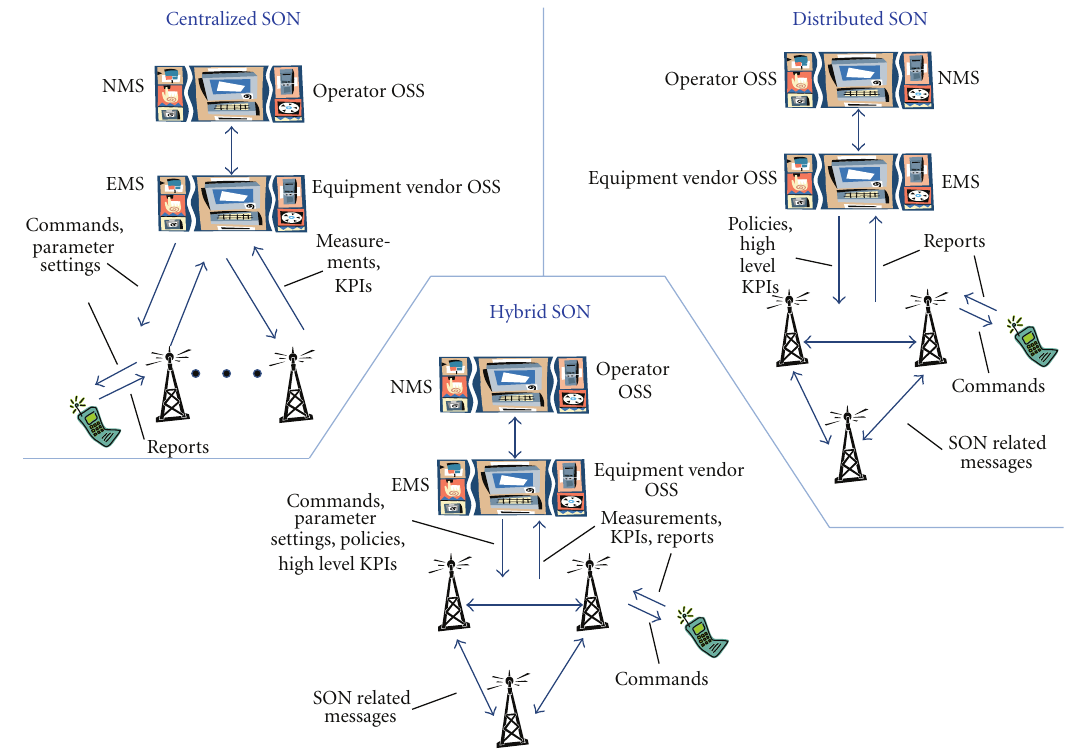
Figure 1: The three SON architecture options (NMS = network management system, EMS = element management system, OSS = operational support